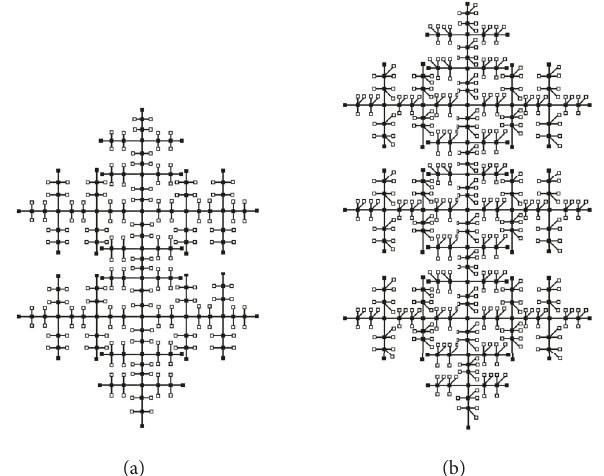
Figure 2: (a)The representation of fractal tree 𝐹 3 for 𝑘 = 2 is illustrated. (b) The representation of fractal tree 𝐹 4 for 𝑘 = 3 is